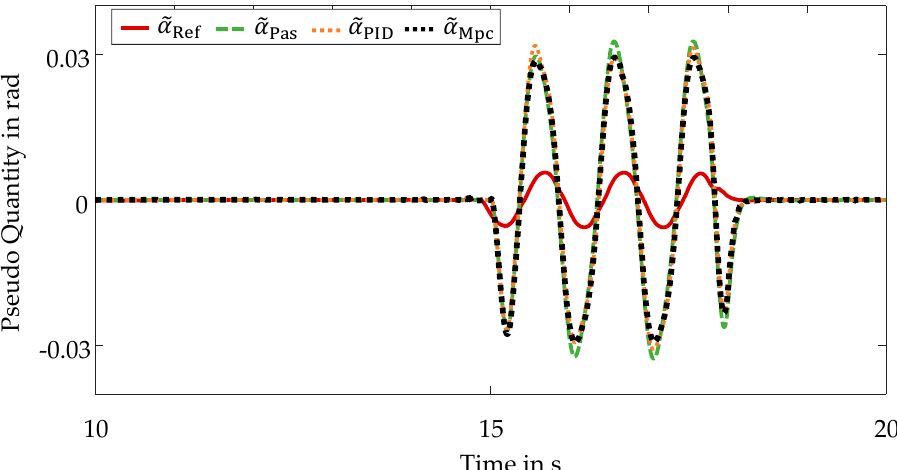
Figure 10. Control Quality Sinusoidal Steering–Self-Steering Behavior–Pseudo Quantity Curves. The non-linear model-based predictive control algorithm results in a root mean squared error of 0.0077 rad corresponding to 0.4412 °. The conventional control approach yields a root mean squared error of 0.0078 rad, which is equivalent to 0.4469 °. In general, the control objective of influencing the self-steering behavior is achieved as well. A self-steering behavior corresponding to the passive self-steering behavior is present despite the application of the central predictive control system.